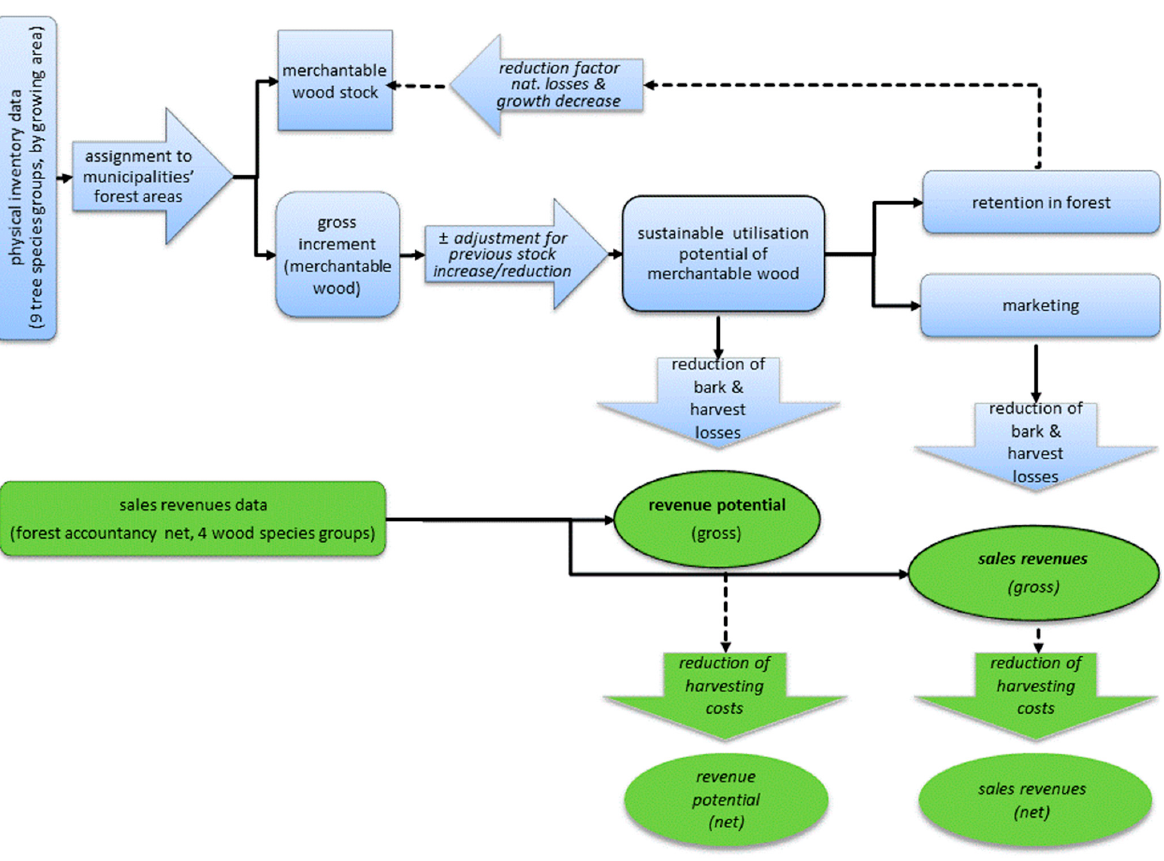
Figure 1. Procedure for quantifying and valuing the timber production service ( italics: not applied here).